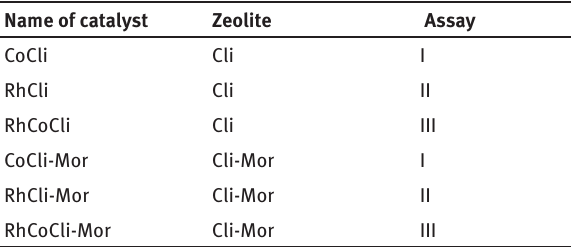
Table 1 : Identification of Catalysts according to assays performed on the zeolite